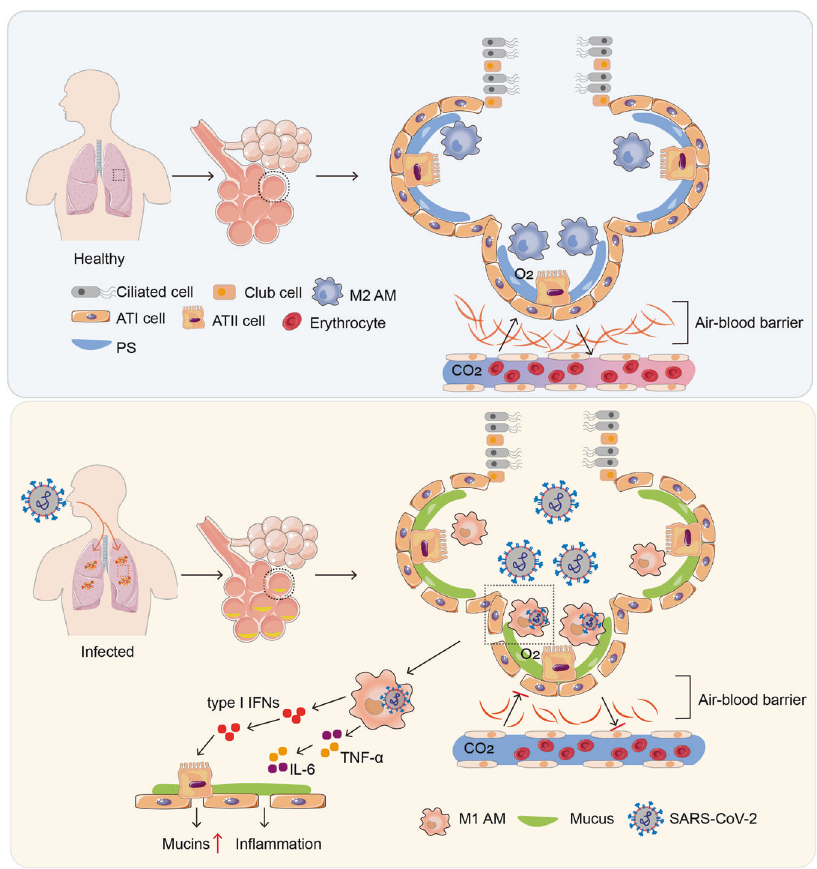
Fig. 2 The pathological features of the lung in SARS-CoV-2-infected patients. In healthy conditions, alveolar epithelia are composed of alveolar epithelial type I (ATI) and ATII cells. ATI cells are squamous cells covering ~95% of the alveolar internal surface area; the other 5% are covered with cuboidal ATII cells, which secrete pulmonary surfactant. Alveolar macrophages (AMs) reside in airspaces, accounting for ~95% of alveolar immune cells, and safeguard against most inhaled irritants. The lung air – blood barrier acts as the site for O 2 and CO 2 exchange. Nevertheless, a certain amount of viruses can cause AMs polarization toward the M1 phenotype. Proin fl ammatory cytokines secreted by SARS- CoV-2-infected M1 AMs abrogate PS production by ATII cells, allowing the new virions released from M1 AMs to gain access to ATII cells. The type I interferons released by infected M1 AMs stimulate ATII cells to produce mucus. However, accumulation of alveolar mucus affects the blood-gas barrier, leading to impaired O 2 – CO 2 yield AMs (Fig. 3). 65 As alveolar guardians, AMs physiologically stable surfactant fi lm stable during breathing cycles. 51 In general, PS complexes are assembled in ATII cells. The lipid fraction and display an M2 phenotype, 67,68 expressing the cell-surface protein surfactant proteins are stored tightly in lamellar bodies (LBs), a mannose receptor C type 1 (MRC1, CD206), which facilitates spherical structure with a diameter of 1 – 3 μ m. 55,56 When the LB- endocytosis and phagocytosis. 15 Thus, AMs act as scavengers to limiting membrane fuses with the plasma membrane of the cells, continually phagocytose inhaled xenobiotics to maintain lung LBs are secreted through the fusion pore, triggered by the surface homeostasis. However, because the respiratory tract is an open tension, hydration, pH, and calcium concentration. 55,57 PS reduces system, AMs are also endowed with high plasticity, allowing AMs to switch from an anti-in fl ammatory M2 state to a proin fl amma- the surface tension in the lung surface liquid and prevents alveolar tory M1 state in response to pathogenic invasion. 69 By recognizing collapse during expiration by decreasing elastic recoil. 53,56 pathogen-associated molecular patterns (PAMPs) with pattern recognition receptors (PRRs) such as Toll-like receptors and NOD- Origin, functions, and plasticity of alveolar macrophages like receptors, AMs can rapidly mobilize NF- κ B and MAPK signaling In addition to maintaining the structure of alveoli, PS acts as a to trigger in fl ammatory responses. 70 – 72 Thus, AMs are the true separator, which blocks access of inhaled particles or pathogens to fi rst-line defender against viral or bacterial invasion of alveoli. alveolar epithelial cells. 58 These xenobiotics, however, can gain Furthermore, the polarization state may profoundly in fl uence the access to and are taken up by AMs, which reside in the PS surface ability of AMs to control SARS-CoV-2 infection. Our fi ndings and the underlying hypophase and account for ~95% of resident provide evidence that M1 AMs have more acidic endosomes but alveolar immune cells. 15,59 Lung macrophages mainly include two more alkaline lysosomes than M2 AMs. These differences cause populations, AMs and interstitial macrophages (IMs). 60,61 Unlike SARS-CoV-2 to mostly replicate in M1 AMs, but not in M2 AMs IMs, which originate from adult hematopoiesis and are maintained which are responsible for early viral control (Fig. 4). 15 by circulating monocytes, 62 – 64 AMs are established in the yolk sac, where erythromyeloid progenitors (EMP) migrate to the fetal liver to form fetal progenitors that give rise to mature AMs in a steady M2-polarized AMs limit SARS-CoV-2 infection and local self-renewal state. 64 – 66 In response to local in fl ammatory Dry cough is a typical symptom of SARS-CoV-2 infection, 73,74 stimuli, blood monocyte progenitors may migrate to the lung and indicating that the virus mainly invades the alveoli. Given the